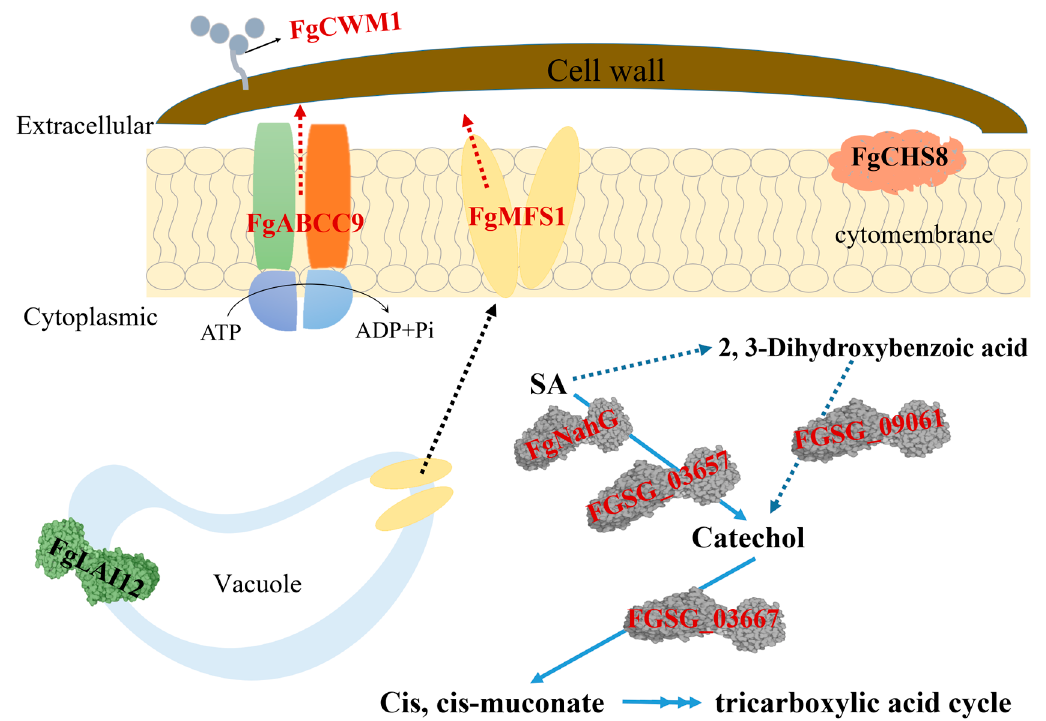
Figure 1. Schematic of the mechanisms on F. graminearum to deal with the toxicity of SA, based on the reported data. Gene names in red and in black indicate the upregulation and downregulation under SA stress, respectively. The red dotted arrows indicate the export of SA. The blue dotted arrows indicate the proposed alternate non-oxidative decarboxylation of SA to catechol via and 2, 3 dihydroxybenzoic acid. The black dotted arrow represents the alternative subcellular localization of FgMFS1 before and after adding SA. FgCWM1 (cell wall mannoprotein 1) is an important component of the outer cell wall and is critical for maintaining the strength of the cell wall. Its expression is up-regulated by SA [21]; FgABCC9 (ATP-binding cassette transporter family C 9) is up-regulated by SA. It is distributed in the cell membrane and cost ATP to export SA [18]; Chitin is a major component of the inner cell wall. FgCHS8 (chitin synthase 8) encodes a chitin synthase (EC 2.4.1.16) that catalyzes polymerization of chitin from UDP-N-acetyl-alpha-D-glucosamine [31,32]. FgCHS8 is an integral membrane protein, and its expression is down-regulated by SA [16]; FgLAI12 (linoleic acid isomerase, EC 5.2.1.5) catalyzes the transformation of linoleic acid to cis-9,trans-11 conjugated linoleic acid. Its expression is down-regulated by SA. FgLAI12 is usually localized in vacuoles even under SA treatment and alternatively expressed in the cell membrane when linoleic acid is added [17]; FgNahG (salicylate hydroxylase, EC 1.14.13.1) catalyzes SA to catechol, which is widely distributed in